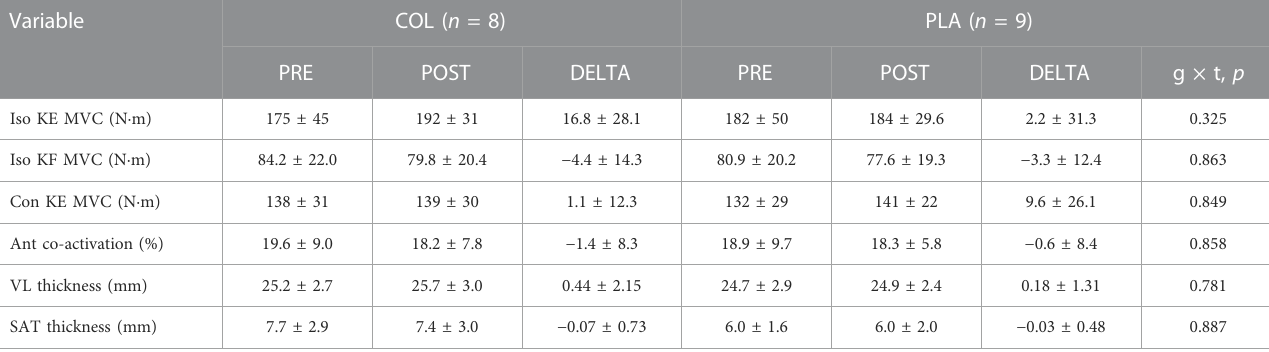
TABLE 4 Knee extension (KE) and knee fl exion (KF) isometric (iso) and concentric (con) maximal voluntary contraction (MVC) torque, antagonist muscle co-activation and vastus lateralis (VL) muscle and subcutaneous adipose tissue (SAT) thickness in COL and PLA groups before (PRE) and after (POST) training. Data are mean ± SD. Variable